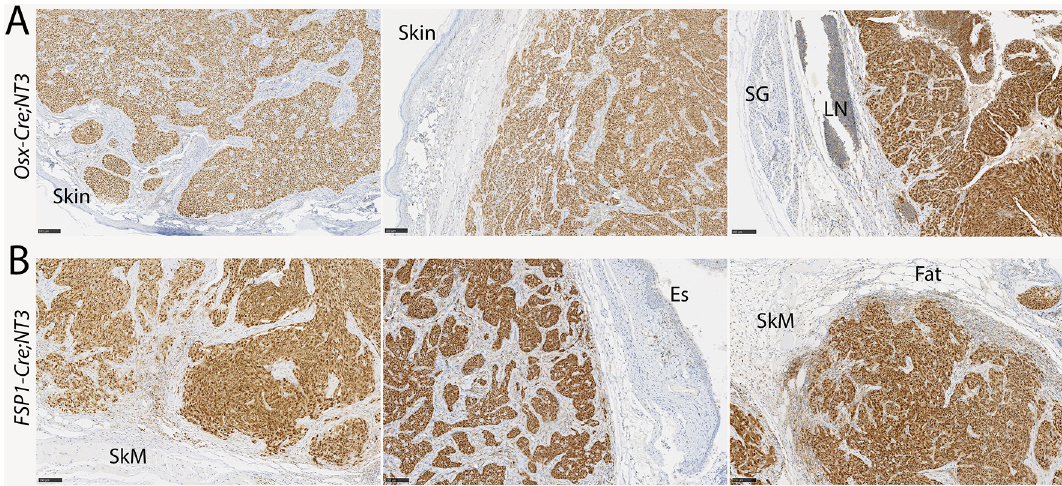
Fig 6. The NT3 transgene activates alternative NF- κ B in tumor cells. Immunostaining for RelB in (A) Osx-Cre;NT3 or (B) FSP1-Cre; NT3 tumors. RelB is uniformly nuclear in malignant cells, indicating robust activation of the alternative NF- κ B pathway. Few cells in adjacent benign tissues show significant staining for RelB. SG, salivary gland; LN, lymph node; SkM, skeletal muscle; Es, esophagus. Scale bars = 100 μ M. n = 3 each